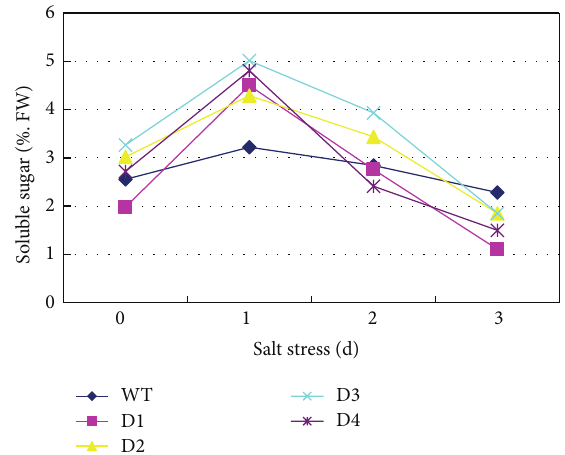
Figure 5: Soluble sugar content in the WT plants and SbPIP1 gene transgenic lines. D1, D2, D3, and D4 represent the transgenic lines D1, D2, D3, and D4, respectively; WT represents the untransformed wheat variety Ningmai